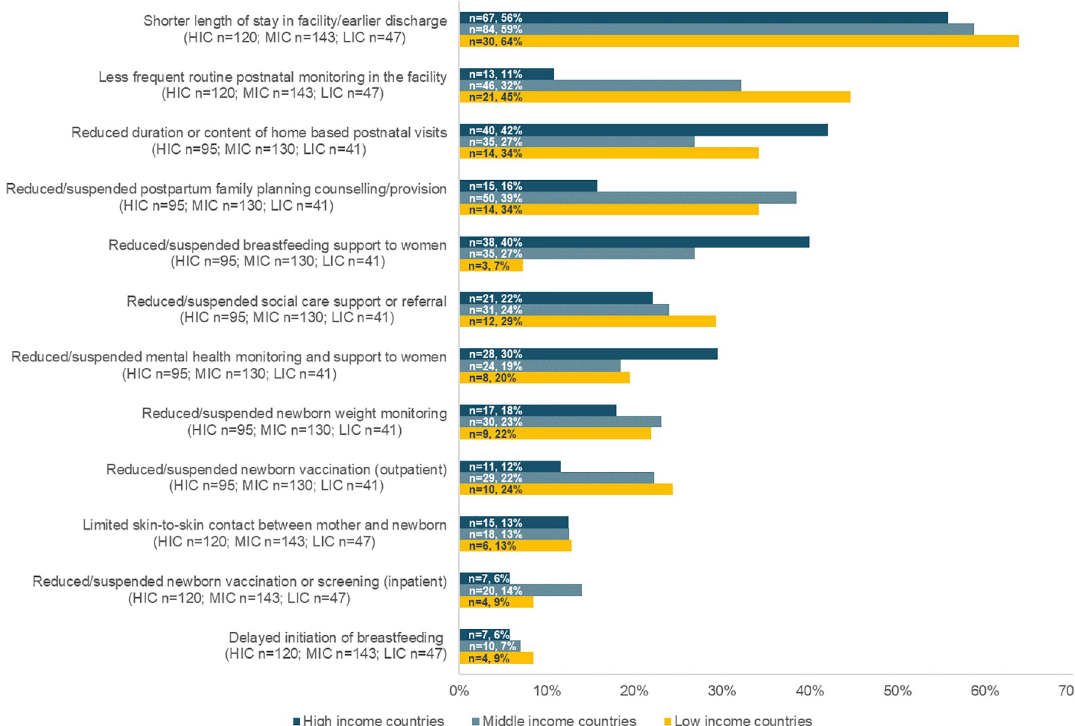
Fig 4. Number and percentage of respondents reporting changes in postnatal care content, by country income level during the month preceding the survey.